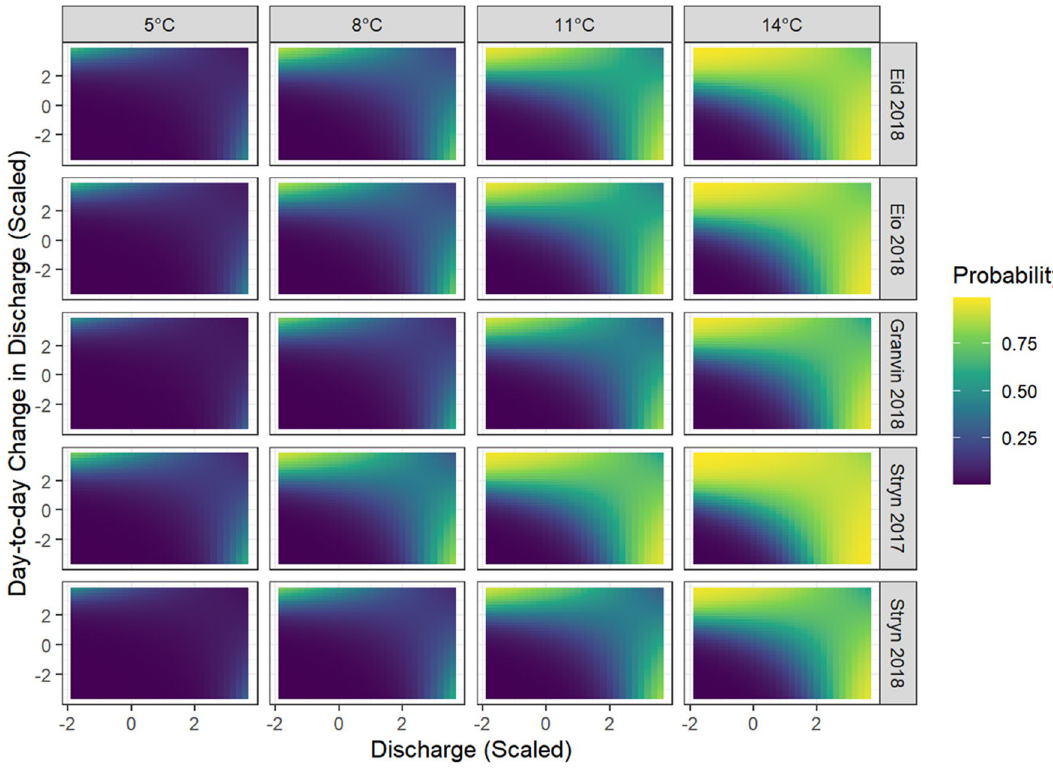
Figure 4. Migration probability predictions from best model of migration triggers. Yellow indicates a high probability of migration and blue indicates a low probability of migration given a set of river